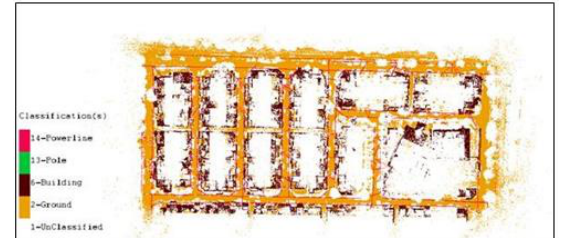
Figure 4 . The result of classification for Mobile LiDAR Data